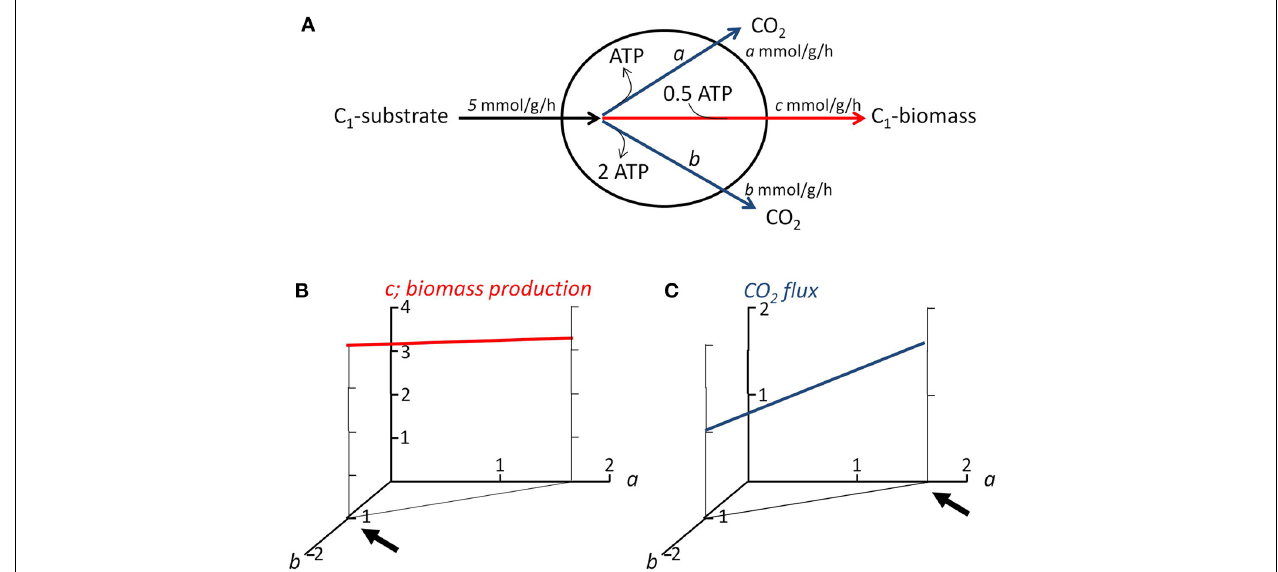
FIGURE 3 | Demonstration of flux balance analysis and objective functions. (A) Simplified representation of the metabolism of a microorganism, e.g, an alkane-degrader. The organism is assumed to consume substrate (formulated as C 1 -unit) at a rate of 5mmol per gram biomass per hour. It grows, at flux c (in mmol per gram biomass per hour) by producing offspring from the substrate, which costs 0.5 ATP per C 1 -unit biomass produced. The ATP needed for anabolism can be derived from two catabolic pathways, pathway a produces 1 ATP per mole C 1 -substrate consumed, pathway b 2 ATP. Two flux balances containing three unknowns ( a , b , and c ) apply in steady state: 1. the carbon going into the cell, must come out: a + b + c = 5; 2. there can be no net